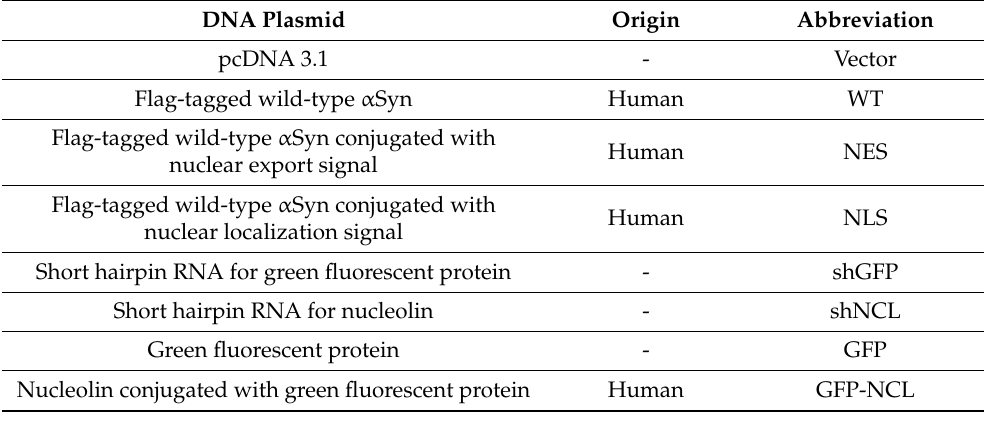
Table 1. The list of DNA plasmids.